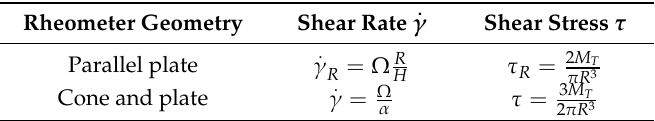
Table 2. Rotational rheometry formulae. R is the plate radius, Ω is the angular velocity, M T is the torque, α is slope of the cone, and H is the parallel plate gap. . Rheometer Geometry Shear Rate